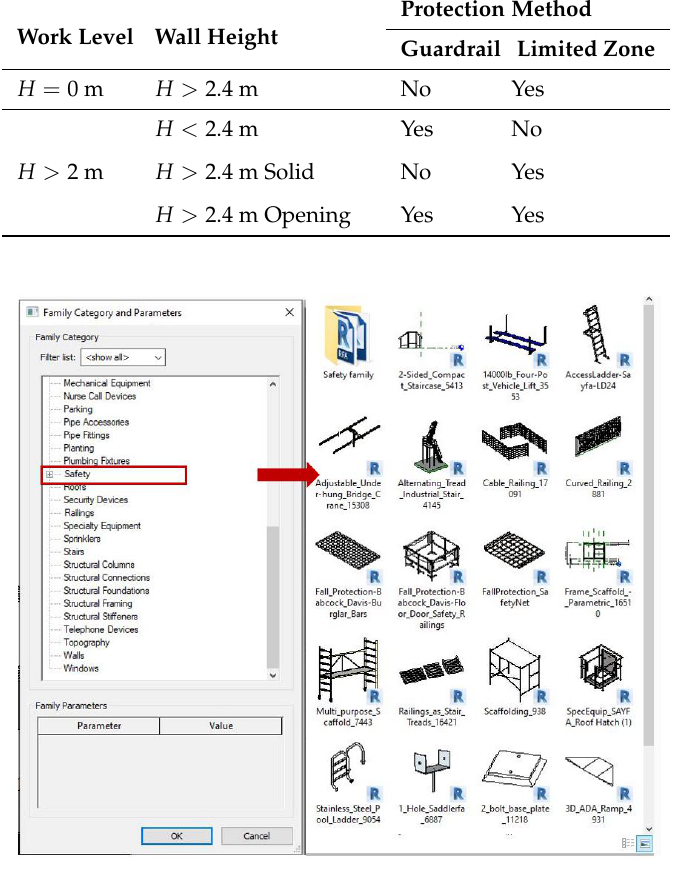
Figure 9. TSF family